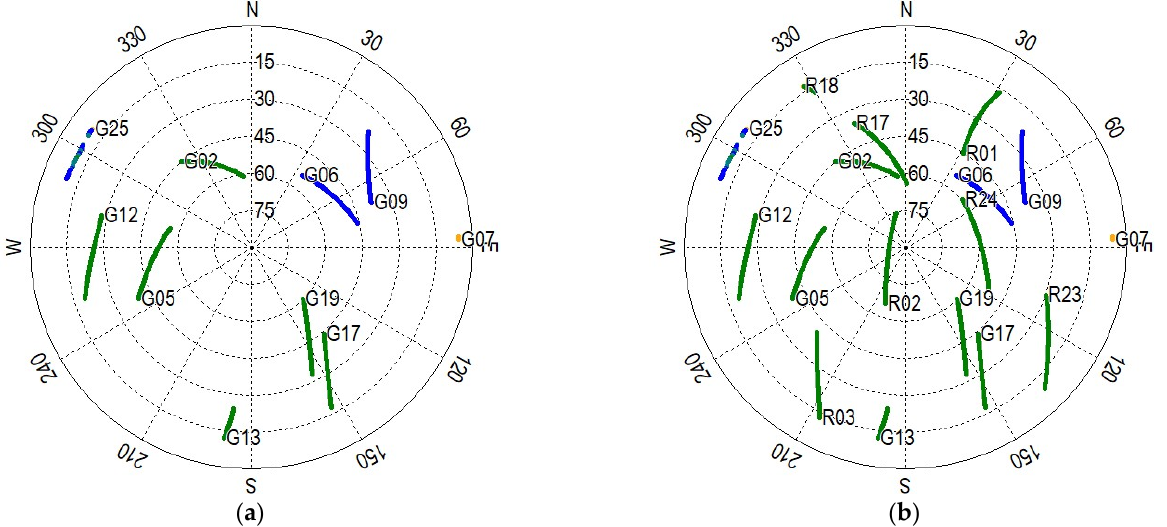
Figure 5. Sky plots of the GNSS satellites (the yellow indicates that only L1 is available, the green indicates that L1 and L2 are available, and the blue indicates that L1, L2 and L5 are available). ( a ) GPS; ( b ) GPS + GLONASS.